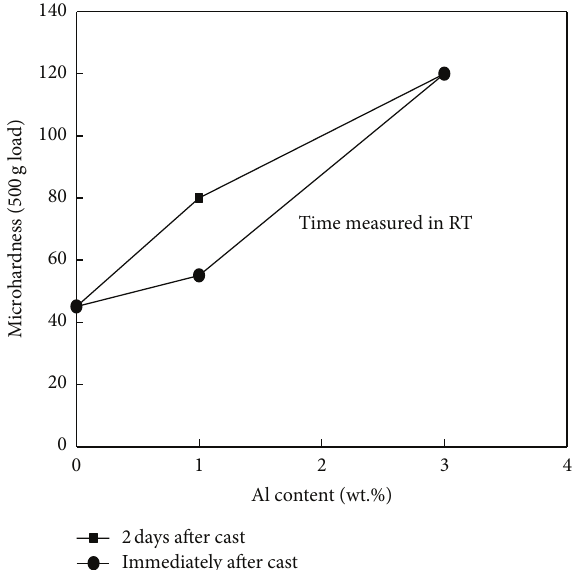
Figure 10: Hardness of as-cast Mg-12Li and Mg-12Li-0.03Be- 𝑥 Al ( 𝑥 = 1, 3 ) alloys with time